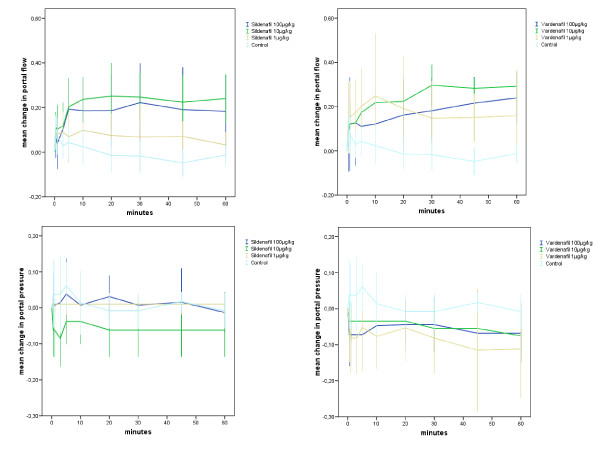
Course of relative changes of portal flow and portal pressure after slow intravenous injection of different doses of sildenafil, vardenafil, or 0.9% NaCl. Ordinate: time (minutes) Abscissa: relative change (e.g. 0.00 means baseline; 0.10 means: increase by 10%; -0.10 means: decrease by 10%). The values are indicated as mean ± 95% confidence intervals. Panel 1: Portal flow. Panel 2: Portal pressure. The values are indicated as mean ± 95% confidence intervals. The curves at different doses are marked by colours.